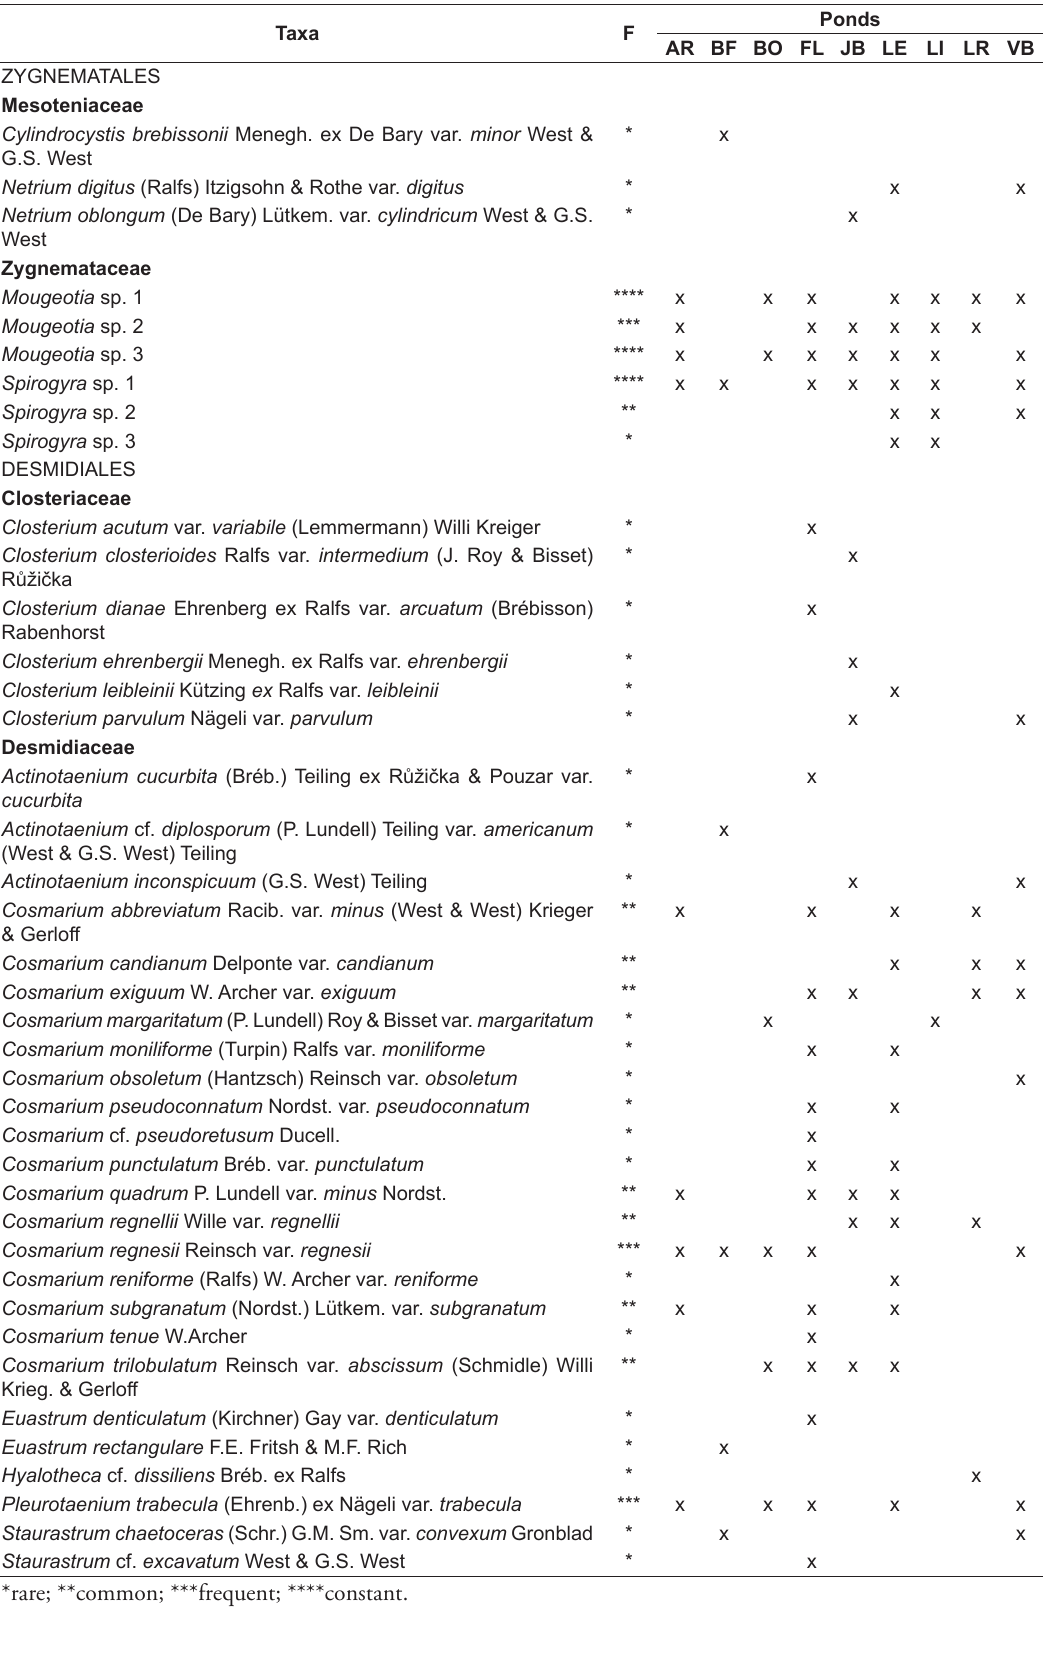
Table 4. Frequency of occurrence (F) of periphytic Zygnematophyceae in nine urban eutrophic ponds from Goiânia, GO. Taxa F